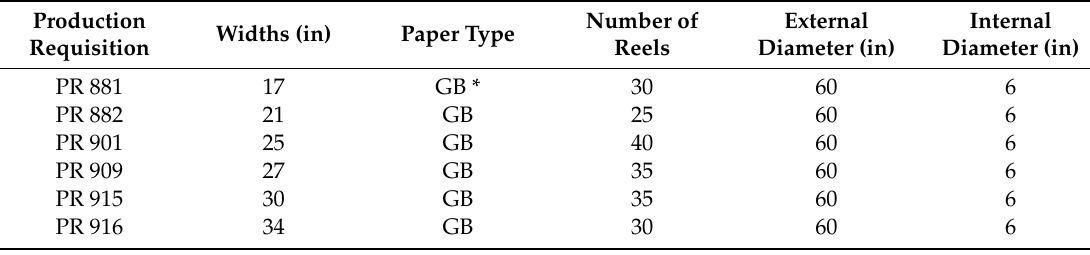
Table 2. Data of a small industrial example.